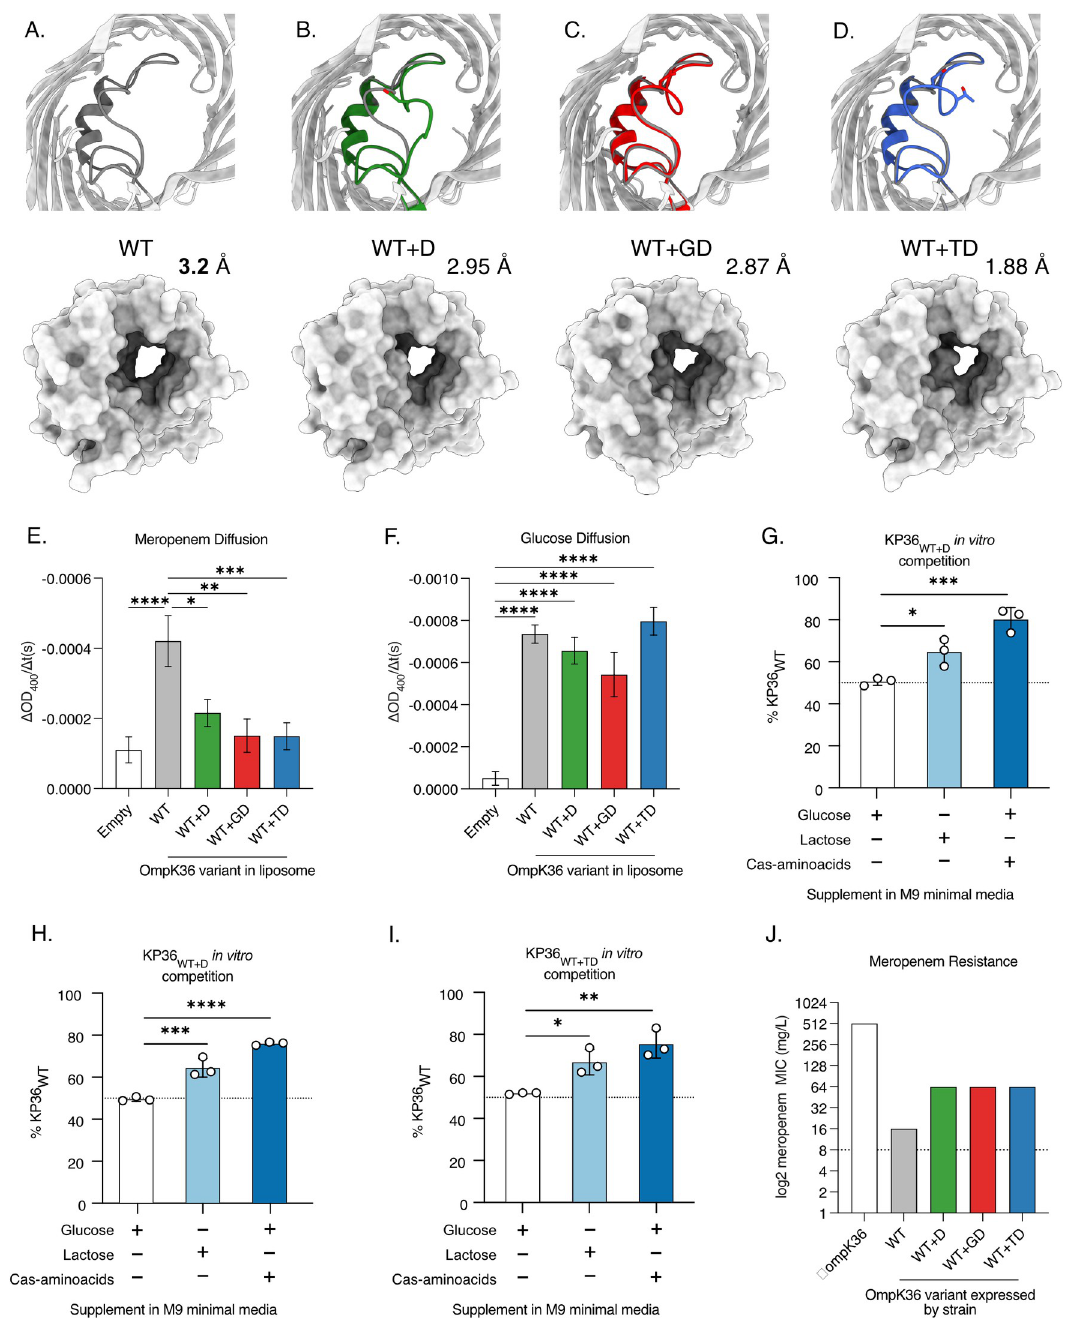
Fig 4. L3 insertions reduce OmpK36 pore diameter and restrict the diffusion of meropenem. A-D. Cartoon illustrations of OmpK36 (grey) in which L3 is coloured for all the variants; the view is from the extracellular space and perpendicular to the membrane (top panels). Insertions in L3 reduce the relative pore radius as calculated by the program HOLE [58]; surface representation to show the impact of the mutations in the pore size (bottom panels). E-F. Rate of diffusion ( Δ OD 400 /t(s) of meropenem (E) and glucose (F) as determined by liposome swelling assays for different OmpK36 variants. G-I: In vitro competition against KP36 WT and KP36 WT+D ( G ), KP36 WT+GD ( H ) and KP36 WT+TD ( I ). No competitive advantage is observed when glucose is added to the M9 minimal media. Lactose and cas-aminoacids supplementation results in outcompetition of L3 insertion expressing strains by KP36 WT . J. Median meropenem MIC values for strains encoding different ompK36 variants ( n = 3 replicates). E-F : All comparisons not shown were non-significant. Error bars ± SEM. � p < 0.332; �� p < 0.0021, ��� p < 0.0002, ���� p < 0.00001, statistical significance determined by ordinary one-way ANOVA with Tukey’s multiple comparison test. G-I: Error bars ± SD. � , � p < 0.332; �� p < 0.0021, ��� p < 0.0002, ���� p < 0.00001, statistical significance determined by ordinary one-way ANOVA with Dunnett’s multiple comparison to glucose supplementation with a single pooled